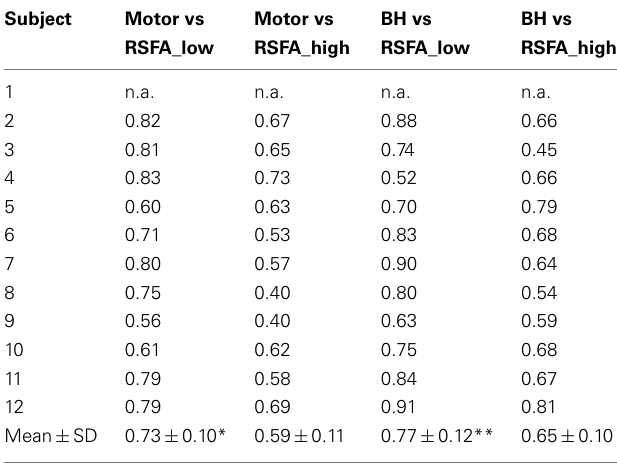
Table 1 | Correlation coefficient values after linear regression of the task-induced BOLD signal amplitude with low and high frequency RSFA in 12 healthy subjects.